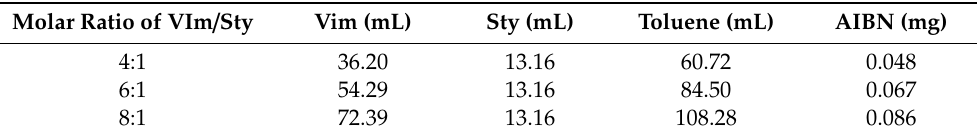
Table 1. Ingredients for free radical